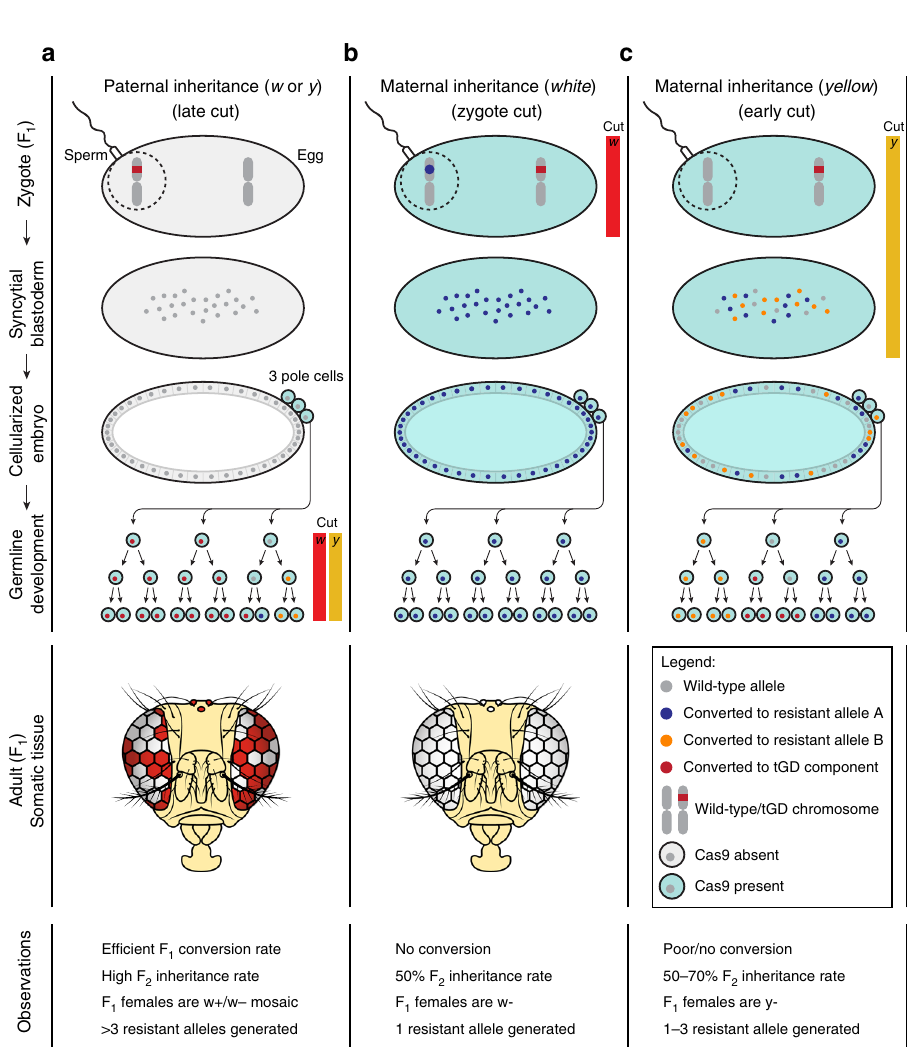
Fig. 4 Model of tGD transgene behavior in males and females. a – c Schematic representation of the different scenarios observed in our tGD experiments when both elements (Cas9 and gRNA transgenes) are inherited together. a When the tGD chromosome (labeled in red) comes from the dad (sperm) any Cas9 activity was detected from zygote to cellularized embryo. The high F 2 inheritance rates in these conditions suggest that Cas9 action (red and yellow bars) is restricted to the germline development phase for the white and yellow genes, allowing ef fi cient conversion (red dots) in this stage. Since the conversion process would occur after three pole-cell formation, this would be consistent with the 1 – 4 resistant allele range (blue and orange dots) captured from F 1 germline females analyzed. b , c We detected different outputs for both yellow and white loci when the tGD chromosome was inherited from the mother. b Cas9 cut (red bar) seems to occur at the zygote stage for the white locus since we only observe one resistant allele per each F 1 germline female that was analyzed. Consistently, this early cleavage event leads to 50% inheritance of our transgene precluding any further conversion event. c Cleavage of the yellow locus by Cas9 (yellow bar) seems to be delayed based on the super-Mendelian inheritance observed in the scored F 2 fl ies from some F 1 germline females. In this case, the Cas9 activity and the conversion process could occur in the zygote or syncytial blastoderm stage, and before the pole-cell establishment. This is reinforced by the the observed range of 1 – 3 resistant alleles (blue and orange